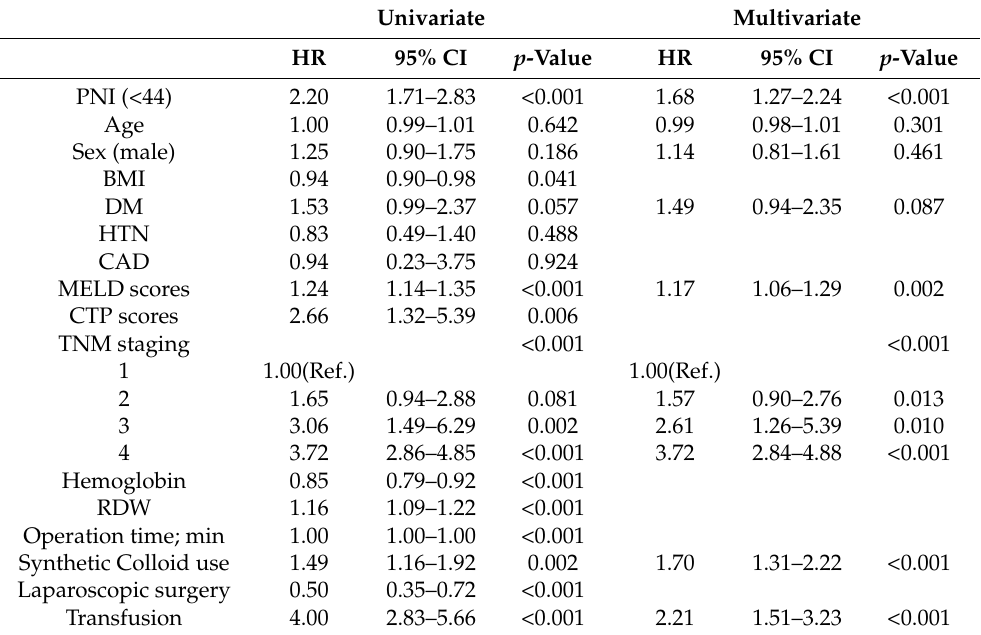
Table 3. Cox regression analysis of risk factors of 5-year survival.